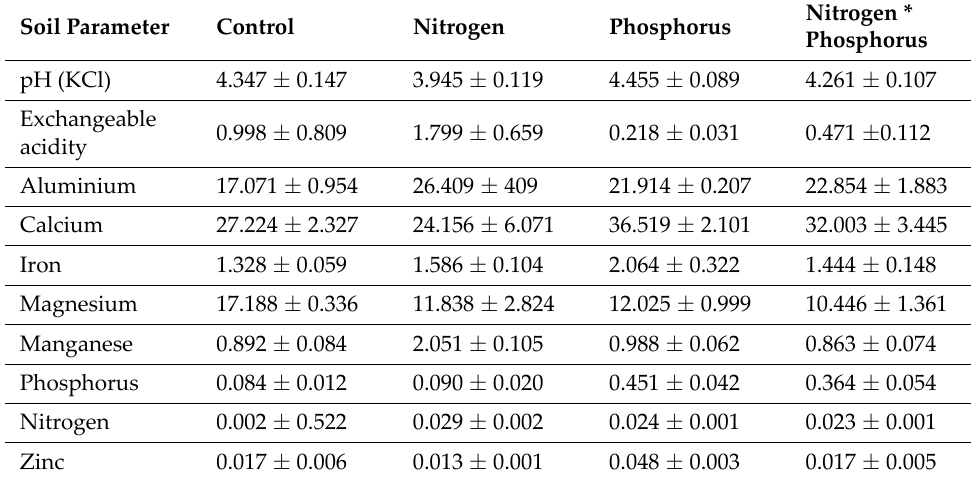
Each value is a mean ± standard error of three